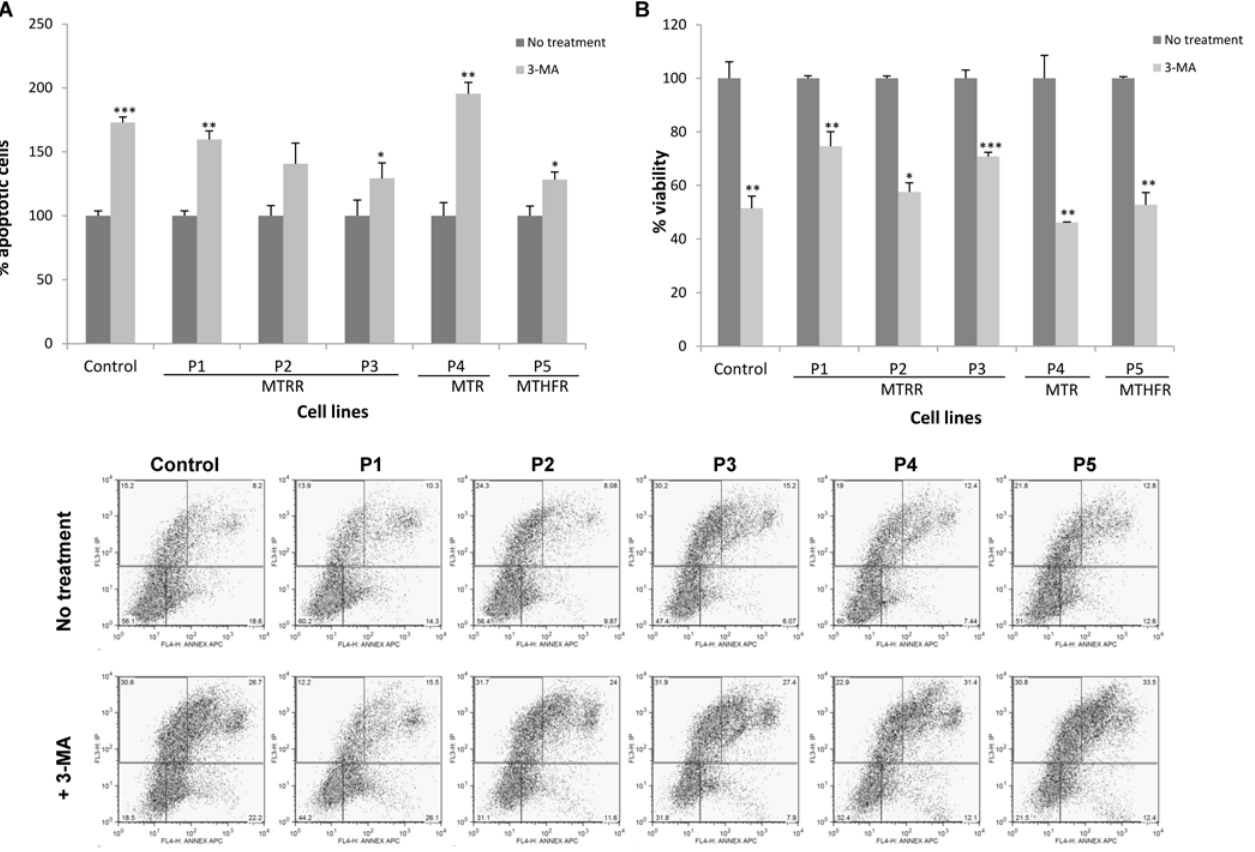
Fig 10. Autophagy inhibition and analysis of apoptosis in control and patients´ fibroblasts by flow cytometry. Cells were incubated for 48h with 20 mM of 3-MA. Data represent mean values ± standard deviation from two experiments performed by triplicate ( * P < 0.05; ** P < 0.01; *** P < 0.001). (A) Percentage of annexinV-positive apoptotic cells in patients and control cells relative to total cell number per sample. (B) Percentage of viability in patients and control cells relative to total cell number per sample. Dot blots from a representative experiment of apoptosis levels are shown.